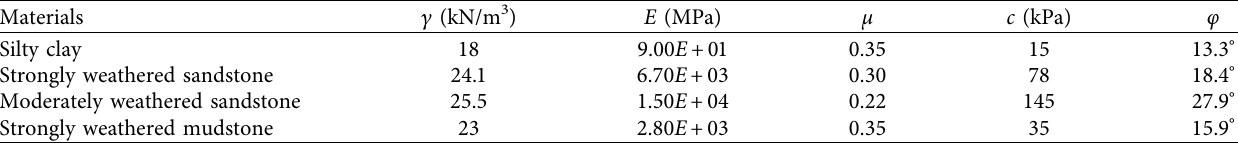
Table 1: Geotechnical parameters under heavy rain conditions.